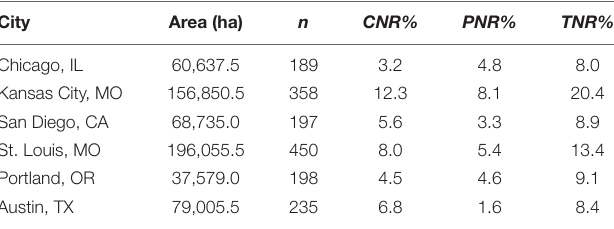
TABLE 1 | Summary information for urban forest inventories from six cities in the United States.